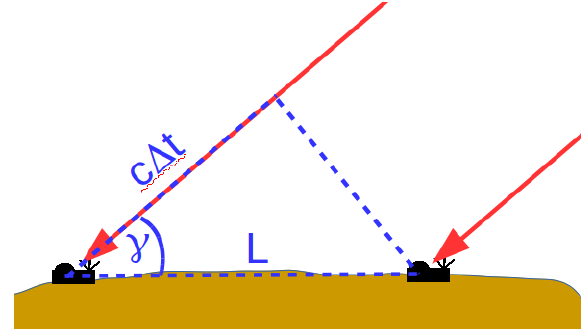
Figure 4. Estimation in two dimensions of the direction of an in- coming Cosmic-Ray Ensemble on the basis of position and time registration in two Figure 2. A smartphone with the CREDO application.